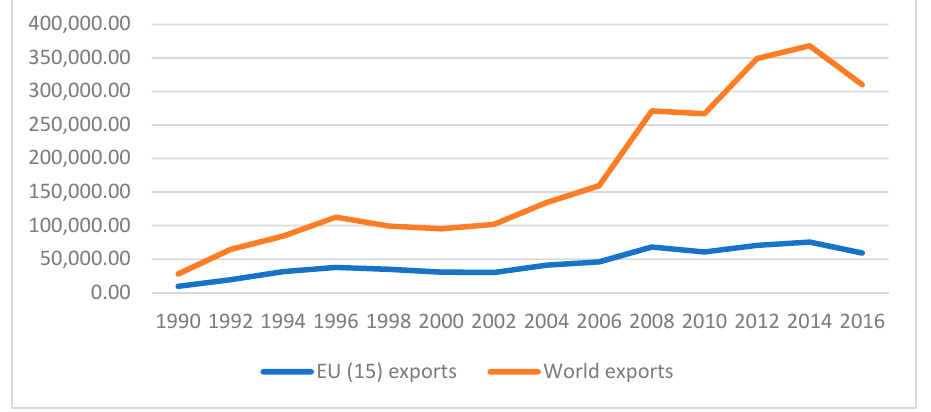
Figure 3. World and EU exports (15) continental products (millions of dollars, current prices). Source: own elaboration from data obtained from UN Comtrade Database.